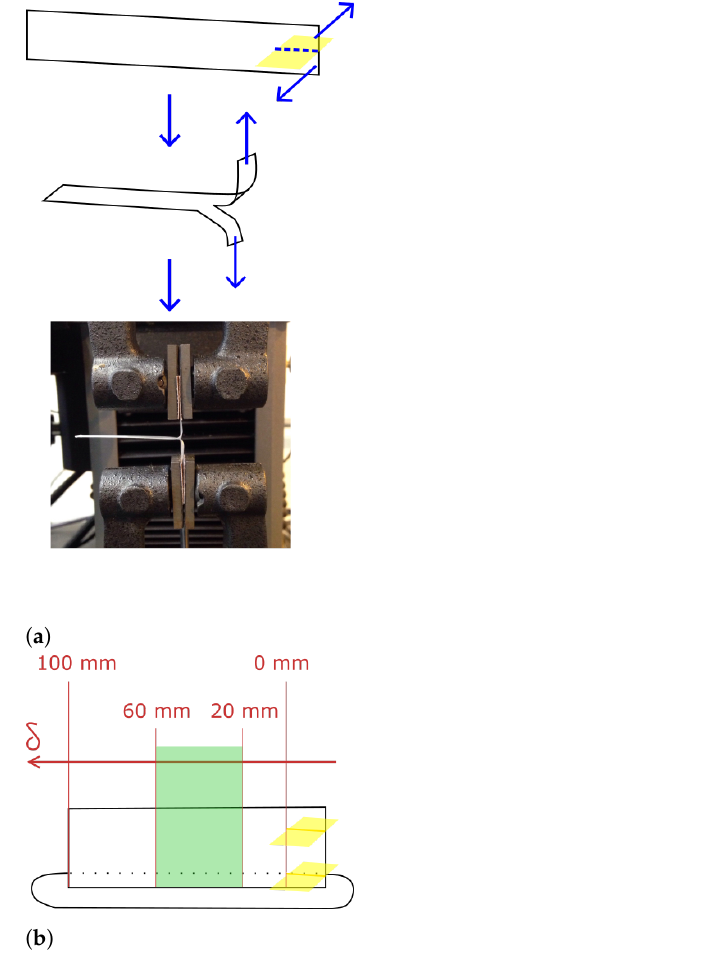
Figure 2. The steps in the employed fracture test methodology with ( a ) loading a specimen for a Mode III fracture test consisting of removing the Kapton tape insert to reveal the pre-crack, followed by clamping the ends on either side of the pre-crack in the pneumatic grips of the tensile tester together with sandpaper, and ( b ) a schematic representation of the region of interest of the wall specimen (green) corresponding to the load data between displacements of 20 and 60 mm, which will be used for data analysis.